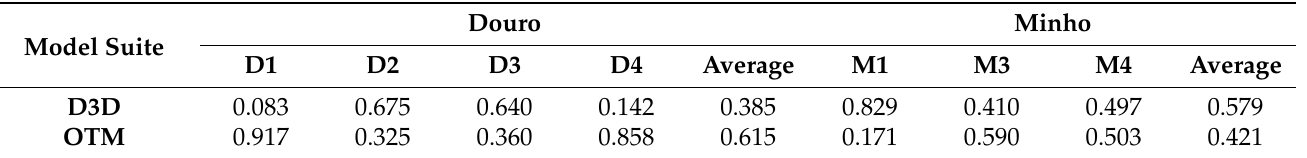
Table 2. Weights considered to construct the superensembles. D1 to D4 (Douro) and M1, M3, and M4 (Minho) were the measurement stations considered to calibrate the ensemble with in situ data (see Iglesias et al. [28] for more